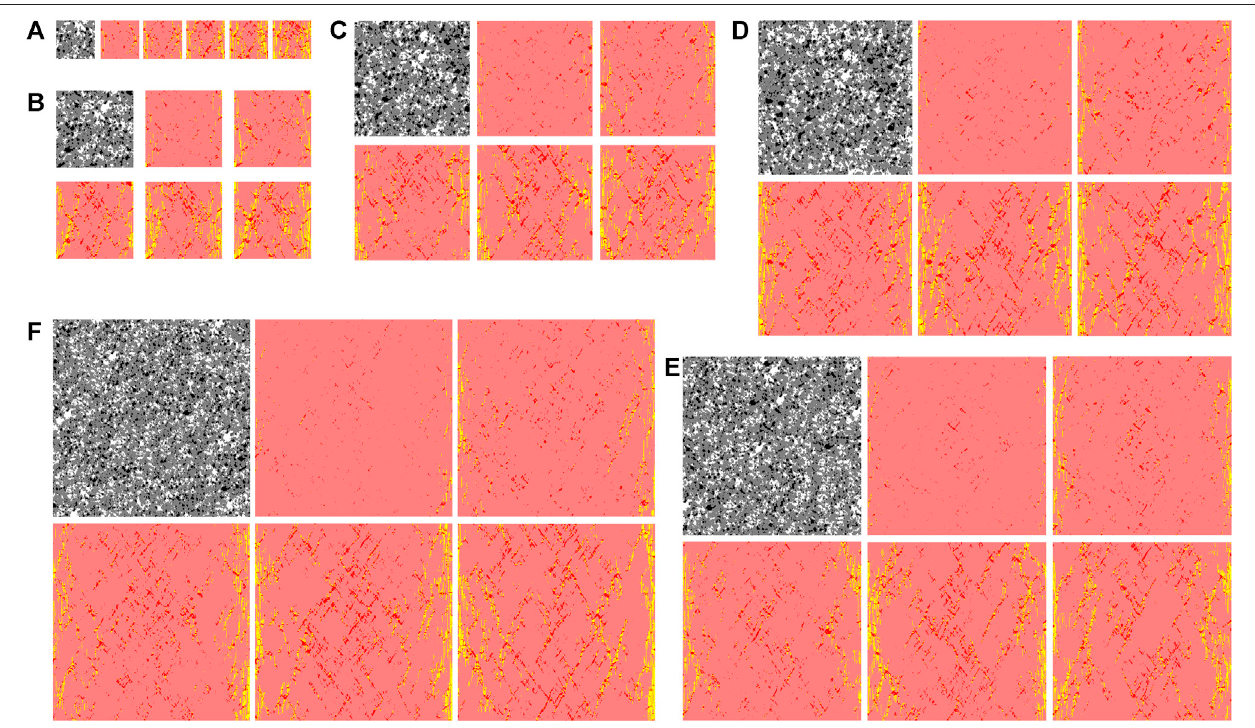
FIGURE 13 | The progressive failure process of digital granite with different sizes. (A) 2.50 cm, (B) 5.00 cm, (C) 7.50 cm, (D) 10.00 cm, (E) 12.50 cm, and (F) 15.00 cm.